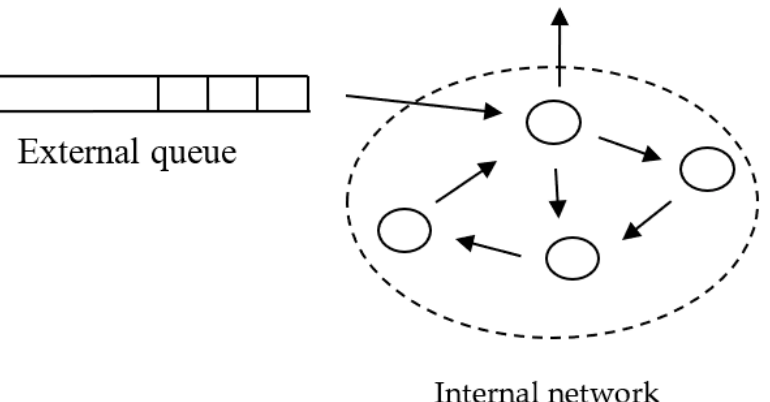
Figure 1. Internal network with a single node in which customers start and finish servicing.